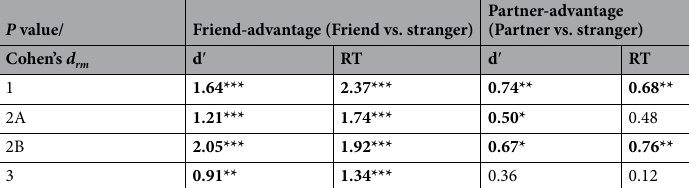
Table 1. Planned pairwise test results ( p values and Cohen’s d rm effect sizes) with Bonferroni adjustments on d ′ and RT of matched trials for all experiments. Friend-advantage refers to friend-related trials versus neutral/ stranger trials. Partner-advantage refers to partner-related trials versus neutral/stranger trials. Significant results are shown in asterisks (*): * P < 0.05. ** P < 0.01. *** P < 0.001. Significant values are in [bold].